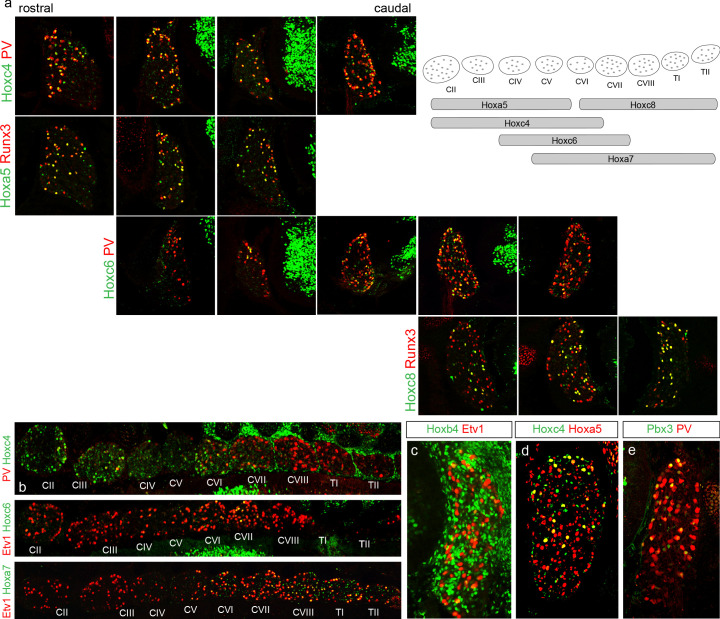
Hox expression pattern of sensory neurons in cervical DRG.(a) Spatial profile of Hoxc4, Hoxa5, Hoxc6, and Hoxc8 expression in DRG along the rostrocaudal axis. Images show coincident expression of Hox proteins with pSN markers. Hoxa5 (with Runx3) and Hoxc4 (with PV) are present in rostral cervical DRG. Hoxc6 (with PV) spans from DRG CIV to CVII while Hoxc8 (with Runx3) is confined to caudal cervical DRG levels. Images shown were obtained from a single embryo, and are representative of N = 3 animals analyzed at this age. Schematic on left indicates Hox expression pattern in cervical level DRG. (b) Longitudinal sections show expression of indicated Hox protein with a pSN markers (PV or Etv1). DRG segmental levels are indicated (CII-TII). (c) Hoxb4+ cells are excluded from Etv1+ sensory neurons at E13.5. (d) A subpopulation of Hoxa5+ SNs coexpresses Hoxc4. (e) Pbx3+ colocalizes with PV+ SNs.